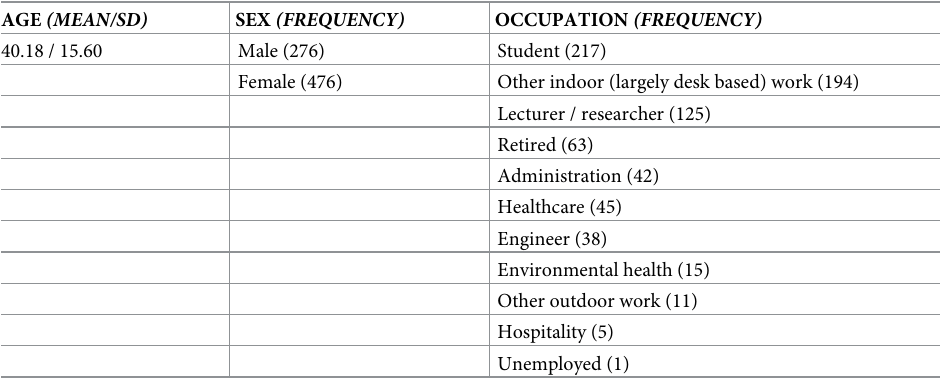
Table 2. Brief demographics of survey